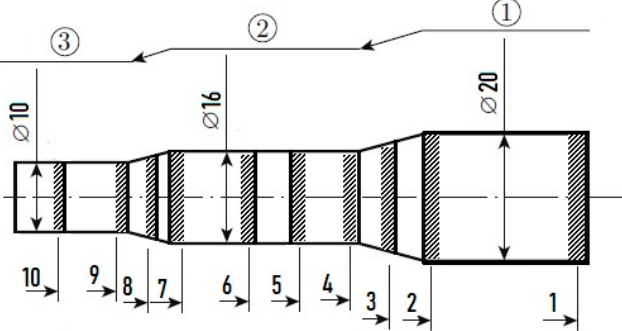
Figure 1. Schematics of cutting-out of samples for metallographic analysis in case of Φ 20 → Φ 16 mm and Φ 16 → Φ 10 mm transitions.